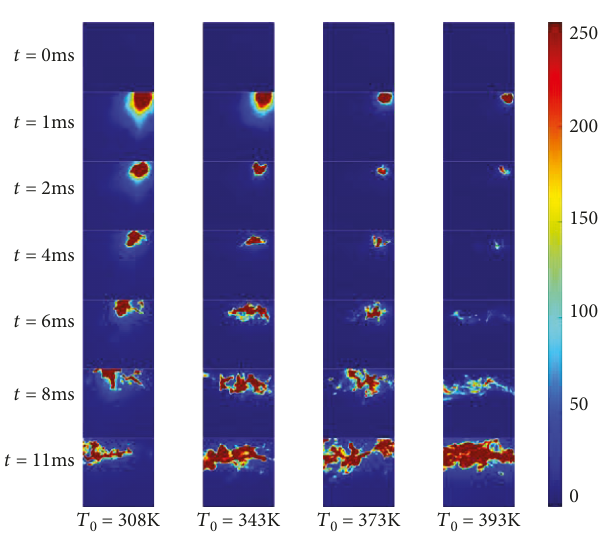
Figure 5: Initial fl ame kernel formation and fl ame